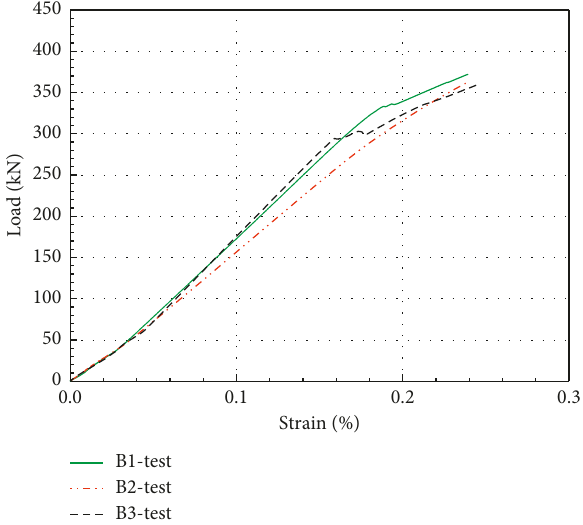
Figure 7: Curves of load-tensile strain in the bottom chord.